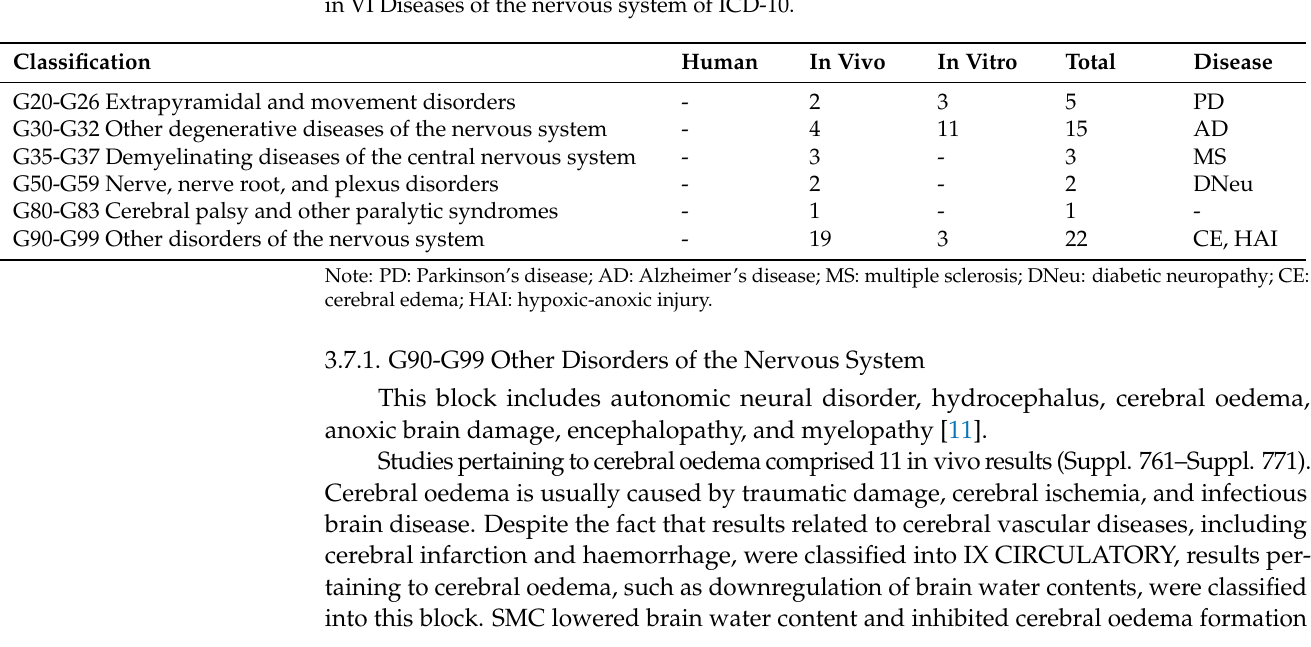
Table 9. The statistics of pharmacological results and its major diseases of SMC by experimental type in VI Diseases of the nervous system of